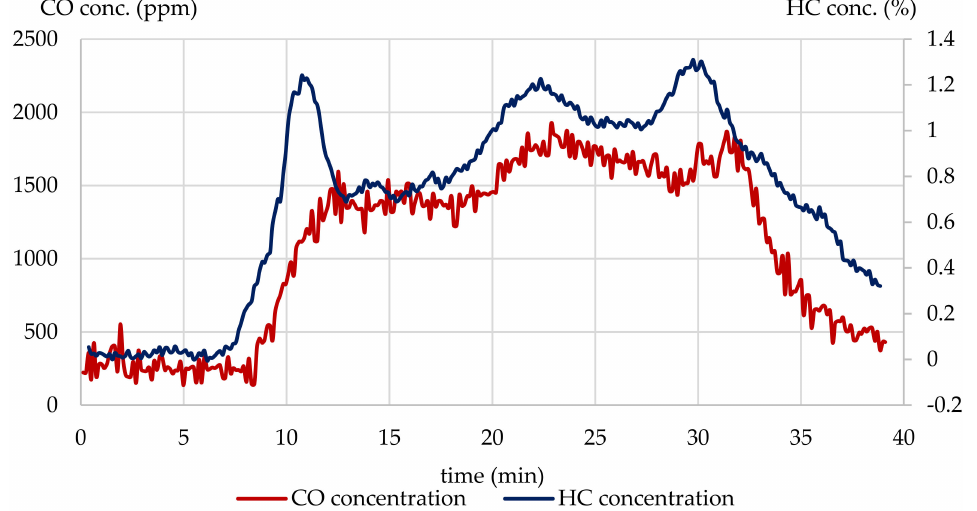
Figure 7. CO and hydrocarbon concentration changes during the steady state combustion test of the H07V-U wire at 15 L / min primary